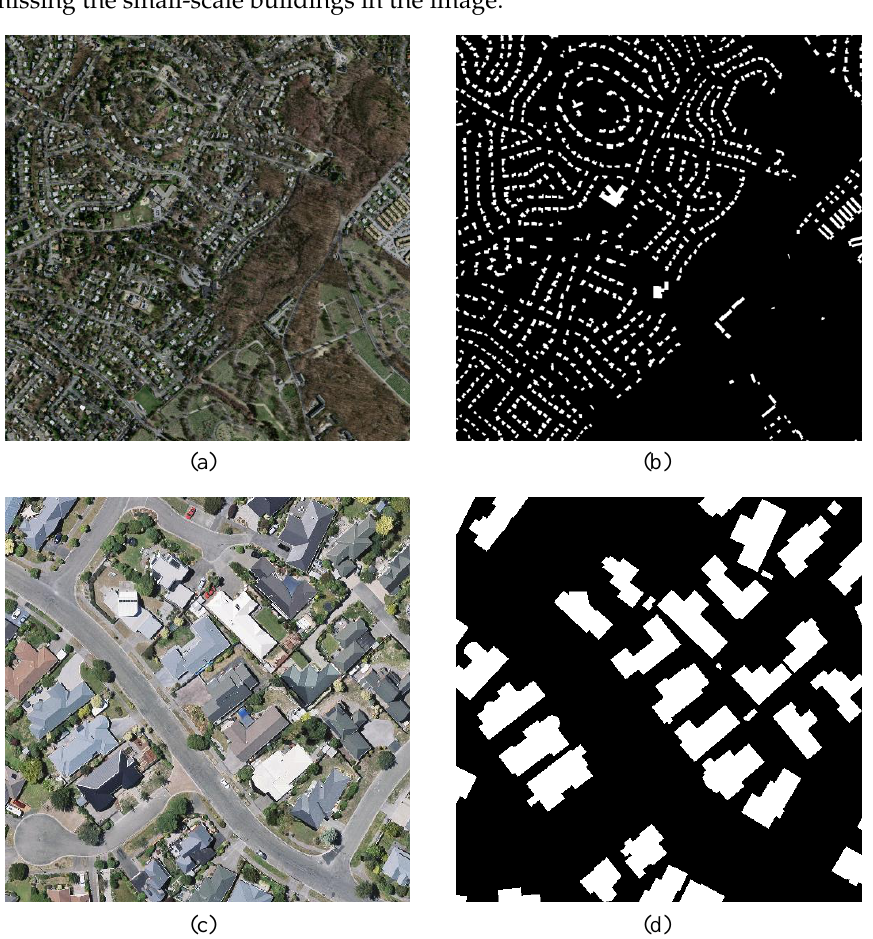
Figure 4. The source and ground truth images in the datasets: ( a ) Massachusetts source image; ( b ) Massachusetts ground truth; ( c ) WHU source image; ( d ) WHU ground